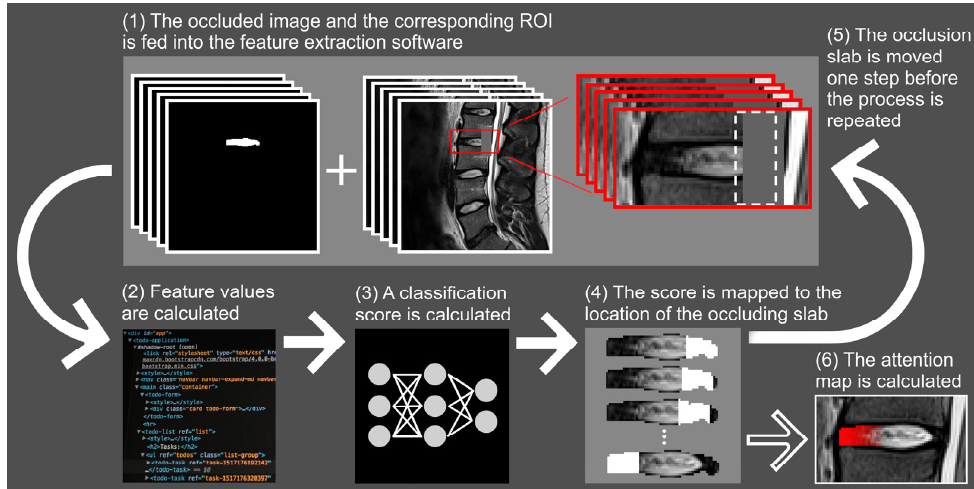
Figure 1. Flowchart displaying the method used to calculate the attention maps. The region of interest (ROI) and the corresponding image of the intervertebral disc overlaid with an occluding slab are fed into feature extraction software ( 1 ). The feature values are calculated ( 2 ) and fed into the artificial neural network to calculate a classification score ( 3 ). This classification score is mapped back to the position of the occluding slab ( 4 ). Next, the position of the slab is moved one pixel in the anterior direction (dashed line in ( 1 )) and the process is repeated ( 5 ). When the occluding slab has populated all positions of the intervertebral disc, the attention map is constructed ( 6